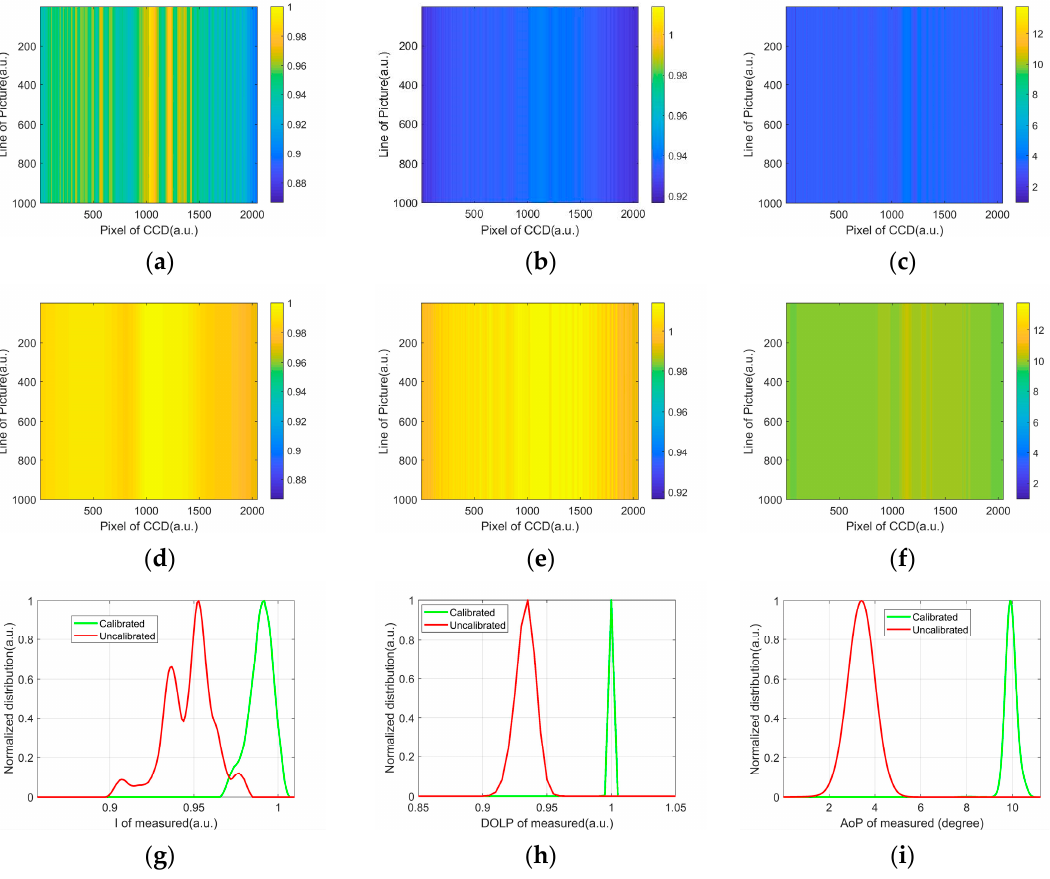
Figure 2. Uncalibrated ( a – c ) and calibrated ( d – f ) results of the scattered intensity I , DoLP , and AoP , and their normalized histograms ( e – i ).